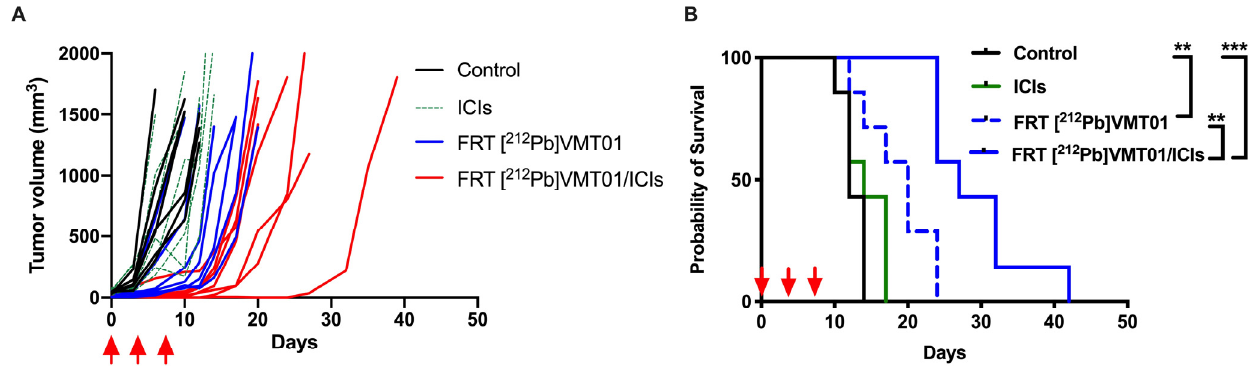
Figure 3. Fractionated dose of [ 212 Pb]VMT01 α -TRT in combination with ICIs in C57BL6 mice bearing B16-F10 melanoma. ( A ) Individual tumor volume in each group of animals after treatments were initiated. Treatments included rat IgG isotype control (control), fractionated 4 MBq [ 212 Pb]VMT01 (FRT [ 212 Pb]VMT01); 200 µ g of anti CTLA-4 + 200 µ g anti PD-1 (ICIs), and combination of FRT [ 212 Pb]VMT01 and ICIs ( n = 7 in each group); ( B ) Overall fractional survival in B16-F10 tumor